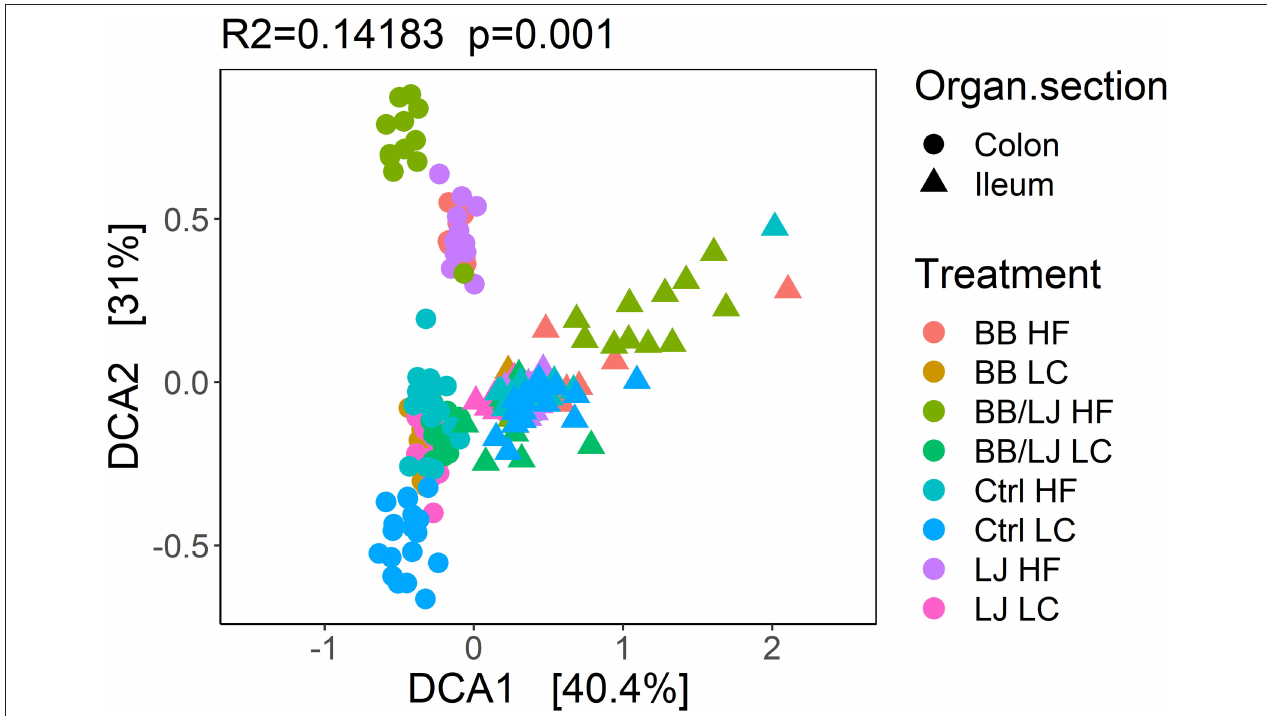
FIGURE 8 | Detrended correspondence analysis (DCA) of the overall samples. PERMANOVA was used to assign statistical significance. HF, control group high-fat diet; LC, control group low-calorie diet; BB, blueberry extract; LJ, L. johnsonii N6.2; BB/LJ, blueberry extract + L. johnsonii